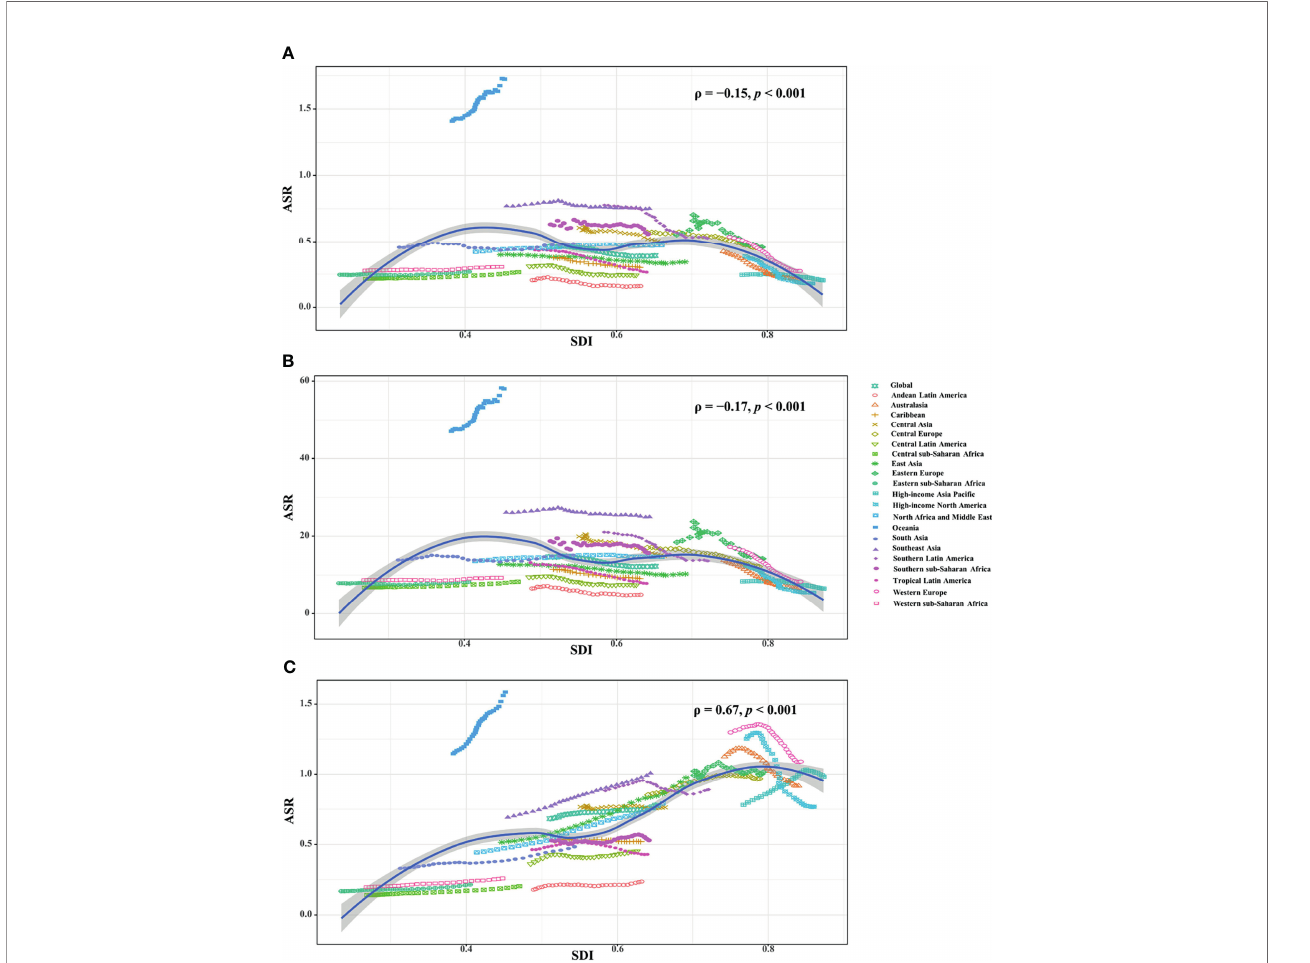
FIGURE 4 | Correlation analysis between ASRs and SDI in 2019 among regions. The ASRs of death (A) and YLLs (B) negatively related with SDI, but that of YLDs (C) positively related with SDI. The correlations were calculated with Pearson correlation analysis. ASR, age-standardized rate; SDI, socio-demographic index; YLLs, years of life lost; YLDs, years lived with